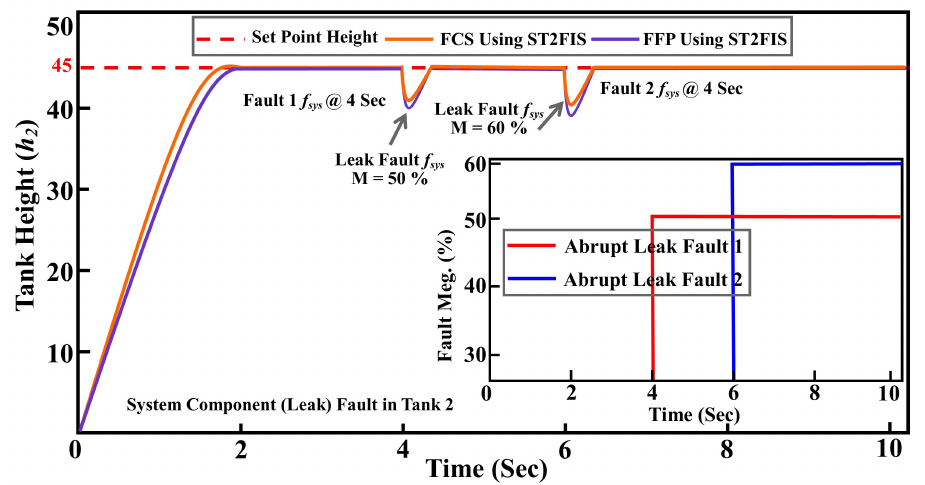
Figure 14. Comparative results of TTCFNLC process subject to system component (leak) fault using fuzzy CS and FP